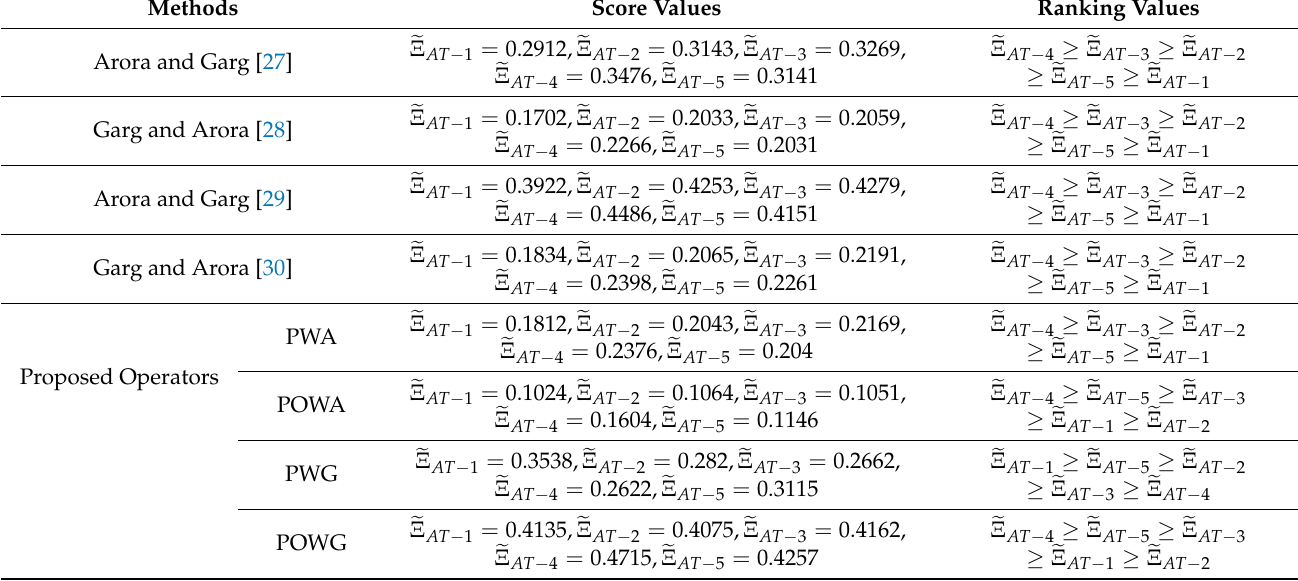
Table 13. Comparative analysis of the existing and elaborated